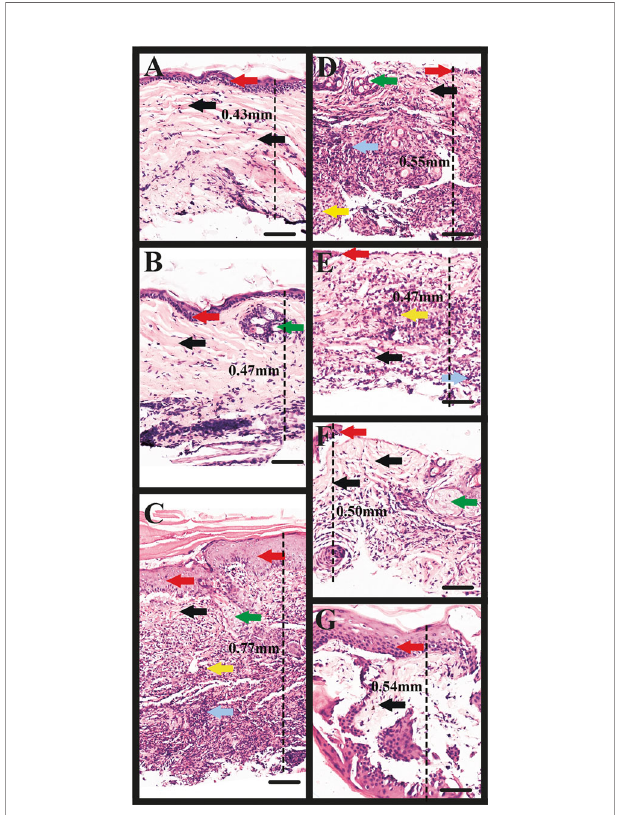
FIGURE 7 | Microscopic image of rabbit skin. (A, B) Control group: the black and red arrows indicate the integrity of the collagen fi bers and epithelium, respectively; the green arrow shows the pilosebaceous unit (the hair follicle and sebaceous gland). (C) Rabbit skin site (ear) bitten by the control ticks (GFP dsRNA-injected). Note the dissociation of collagen fi bers (black arrows), and the in fl ammation of the epithelium (red arrows), in fl ammatory in fi ltrate/granulocytes (yellow arrow), haemorrhage (grey arrow), and part of the pilosebaceous unit (green arrow). (D) Rabbit skin site (ear) bitten by TCP-silenced ticks. Note the concentration of in fl ammatory in fi ltrate/ granulocytes, predominantly heterophiles/neutrophiles (yellow arrow), haemorrhage (grey arrow), the dissociation of fi bers (black arrow), disruption of the epithelium (red arrow), and pilosebaceous unit (green arrow). (E) Rabbit skin site (ear) bitten by ADF-silenced ticks. Observe the in fl ammatory in fi ltrate/ granulocytes (yellow arrow), haemorrhage (grey arrow), dissociation of fi bers (black arrow), and depletion of the epithelium (red arrow). (F) Rabbit skin site (ear) bitten by PD-silenced ticks. Observe the less dense dermis and dissociated fi bers (black arrows), disrupted epithelium (red arrow), pilosebaceous unit (green arrow). (G) Rabbit skin site (ear) bitten by SPK- silenced ticks injected with serine/threonine-protein kinase (SPK) dsRNA (SPK knockdown). Note the disorganized dermis and fi bers (black arrow), and in fl amed epithelium (red arrow). Observe the increase in skin thickness (increased distance between the epidermis and the muscle/subcutaneous layer) as measured in the microscopic images (C – G) , which characterizes oedema. TCP, Tudor domain-containing protein; ADF, Actin-depolymerizing factors; PD, Programmed cell death protein; and SPK, Serine/threonine- protein kinase. Scale bars: 100